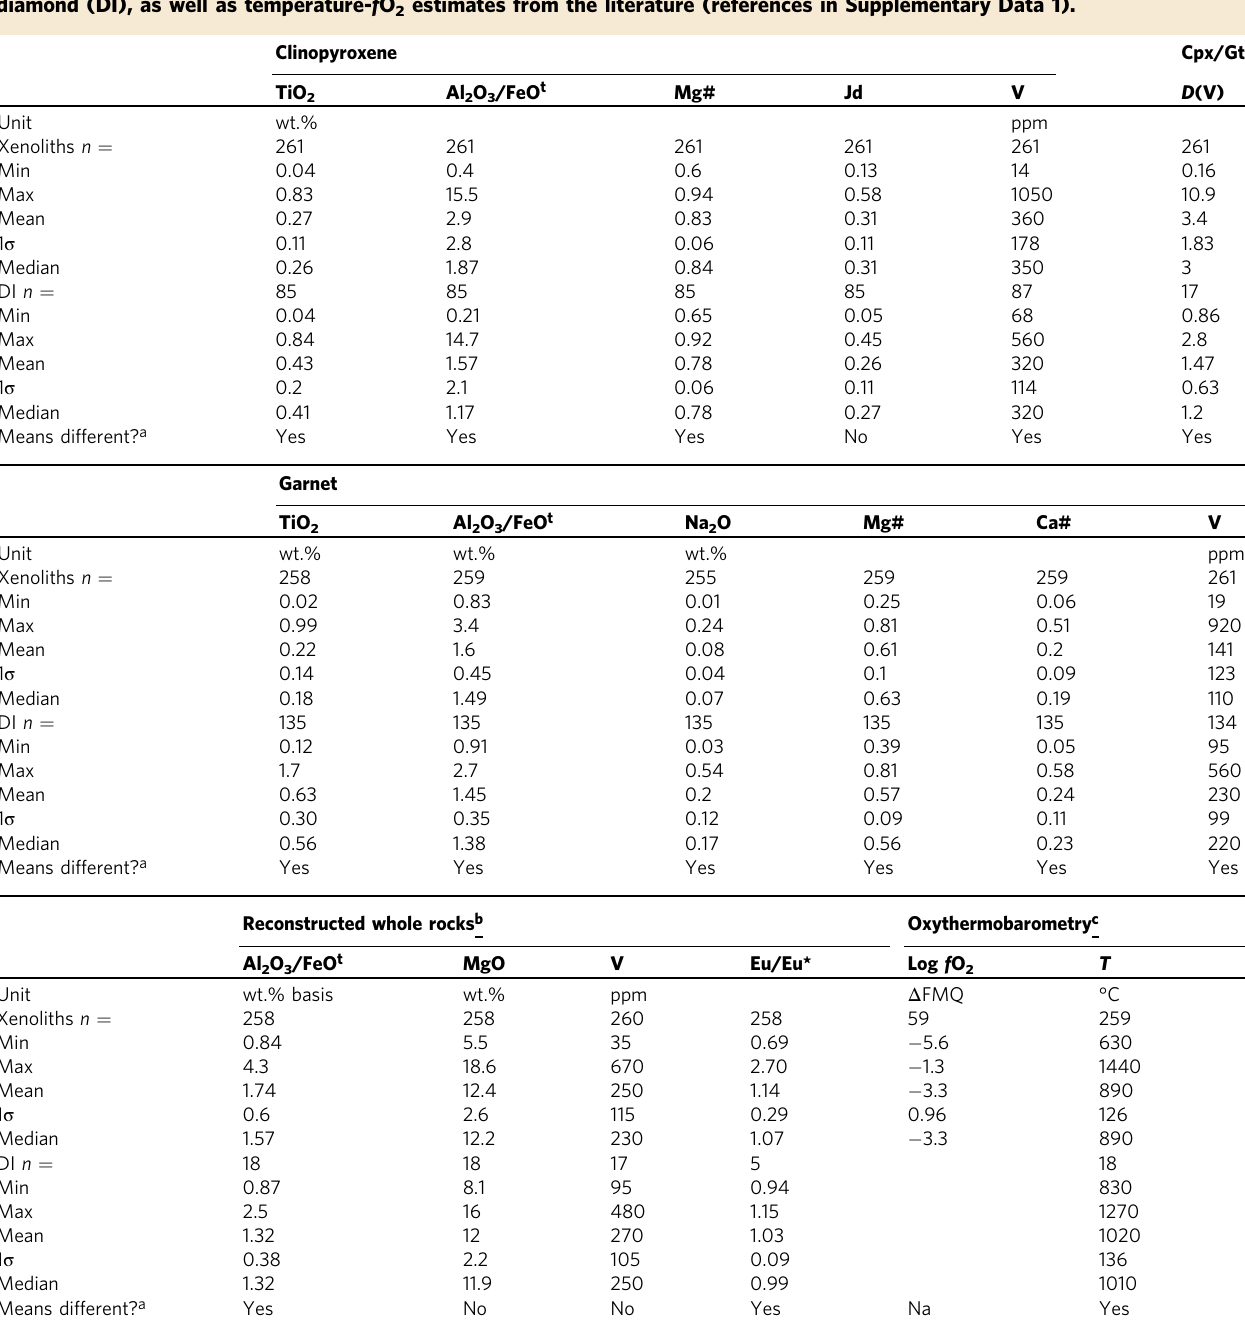
Table 1 Salient parameters of clinopyroxene, garnet and reconstructed whole rocks in eclogite xenoliths and inclusions in diamond (DI), as well as temperature- f O 2 estimates from the literature (references in Supplementary Data 1).